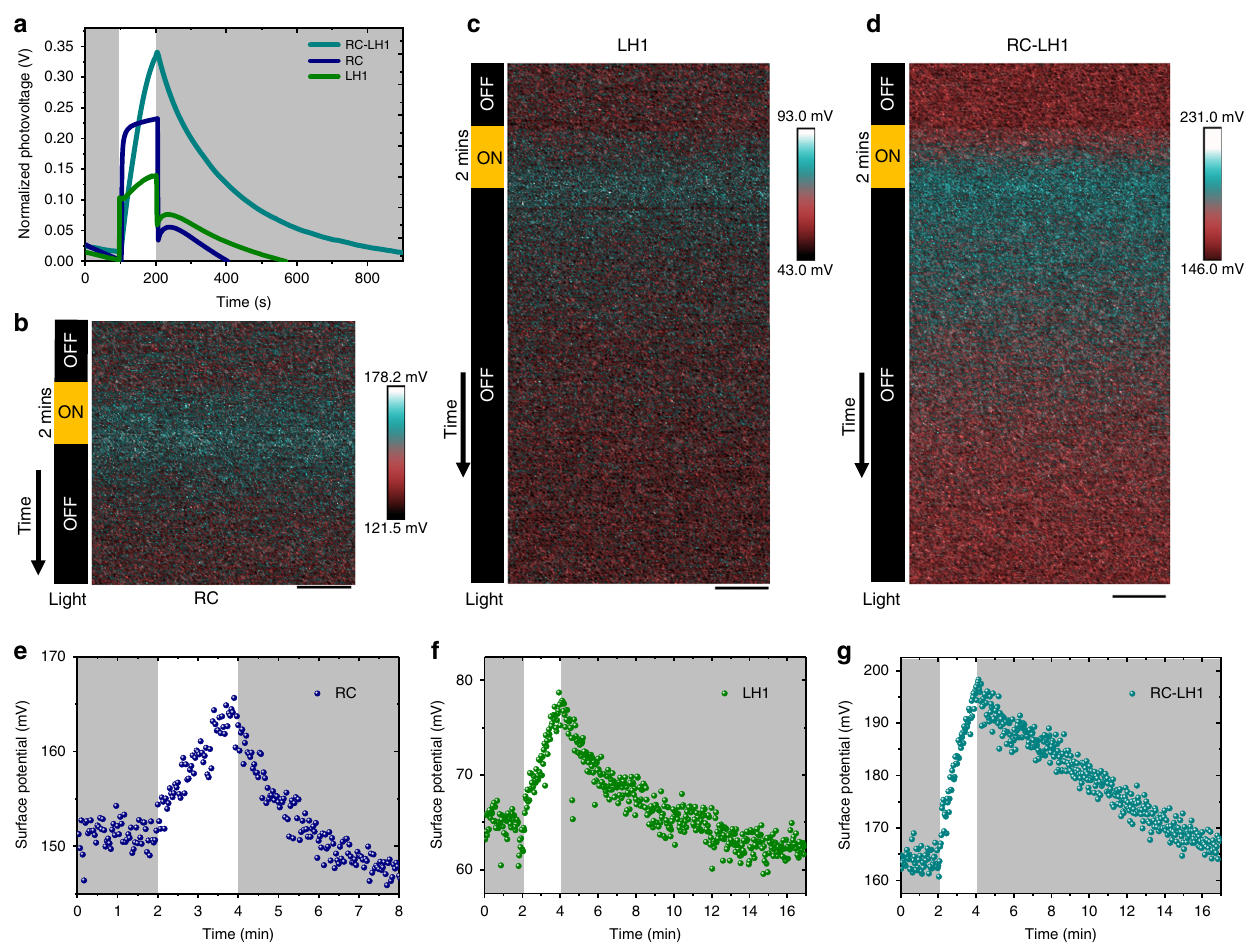
Fig. 4 Photocharging and dark discharging of photoprotein fi lms. a Bulk charge – discharge characteristics of 500 μ m fi lms of three different photoproteins namely, reaction centres (RC), light harvesting 1 complexes (LH1) and reaction centre-light harvesting 1 complexes (RC-LH1), exposed to 100 s illumination. b – d KPFM (Kelvin-probe force microscopy) surface potential maps of b RC, c LH1, and d RC-LH1 fi lms before, during and after a 2 min period of illumination; scale bars denote 200 nm. e – g Changes in surface potential before, during and after a 2 min period of illumination of e RC, f LH1, and g RC-LH1 fi